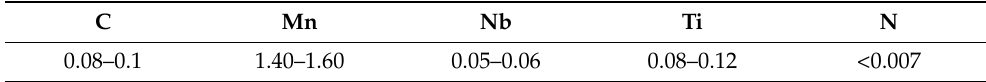
Table 1. Chemical composition of the alloy subject to study (in weight